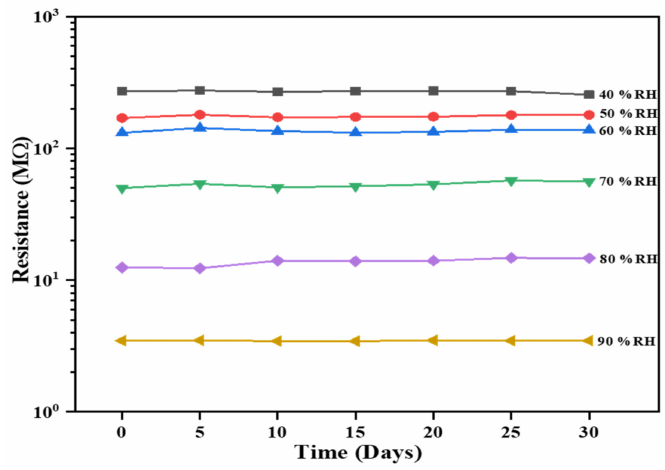
Figure 17. Stability over time of the Al:ZnO-4 h nanostructured-based flexible humidity sensor exposed to 40%, 50%, 60%, 70%, 80%, and 90